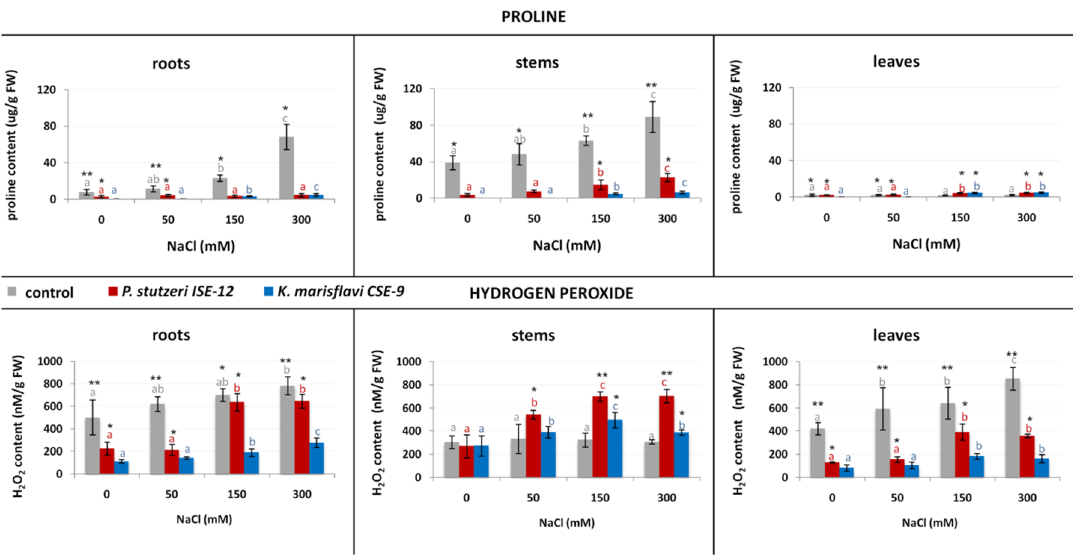
Figure 4. Proline and hydrogen peroxide concentrations in the roots, stems and leaves of the control (noninoculated), P. stutzeri- and K. marisflavi -inoculated B. vulgaris growing in substrates enriched with different NaCl concentrations (0, 50, 150 and 300 mM). Mean values ± standard deviation are presented ( n = 3). Significant differences (based on p < 0.05, df, MS and p value, one-way ANOVA with Tukey post hoc comparisons) between variants of experiment (noninoculated control; inoculated with P. stutzeri ISE-12 and K. marisflavi CSE9) in each NaCl concentration are denoted by different marks * and **, while effect of salinity for each variant is marked with different letters, including gray font for control variant, orange font in the case of P. stutzeri ISE-12 treated variant and blue font for K. marisflavi CSE-9 inoculated plants).